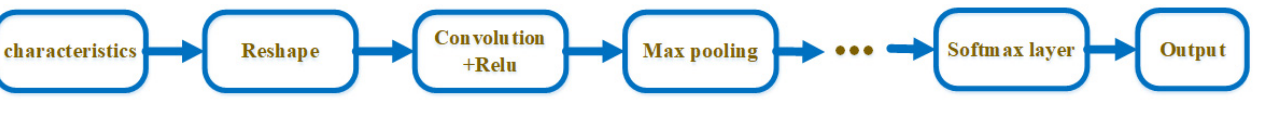
Figure 3. The procedure of CNN layout.